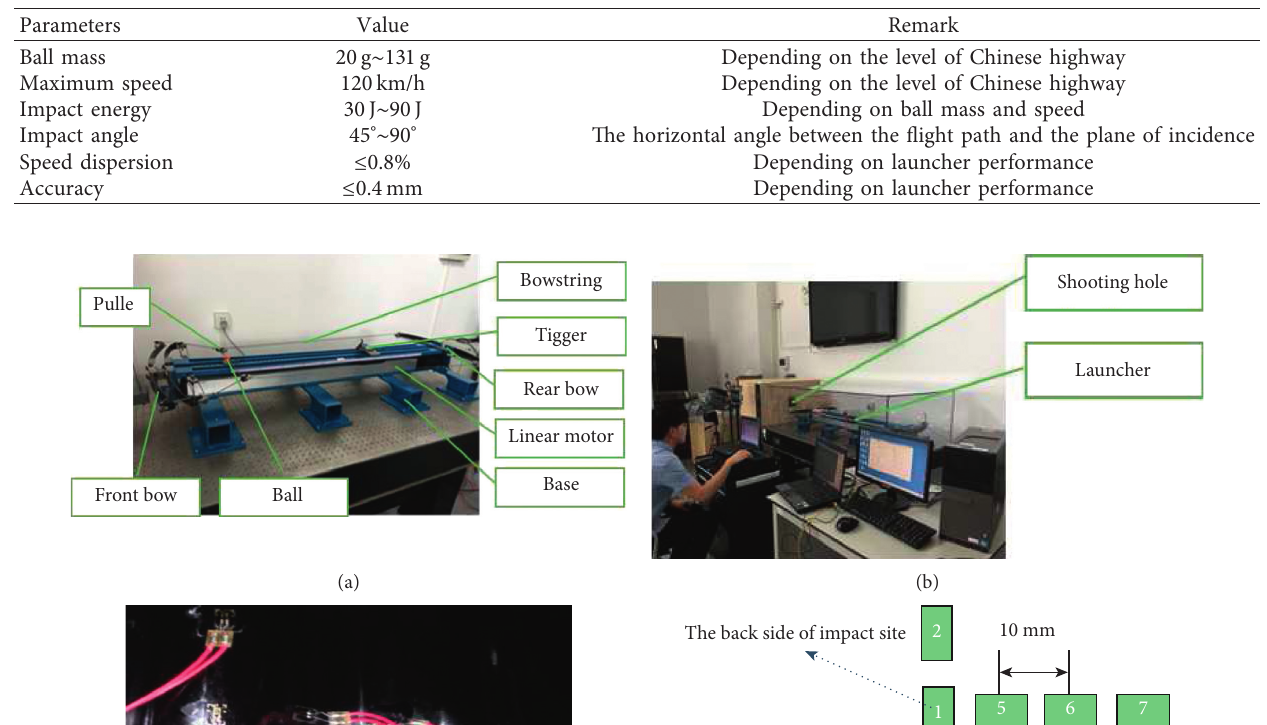
Figure 1: Steel (right) and glass fiber reinforced plastic (left) automobile oil sump. Table 1: The range of test parameters.